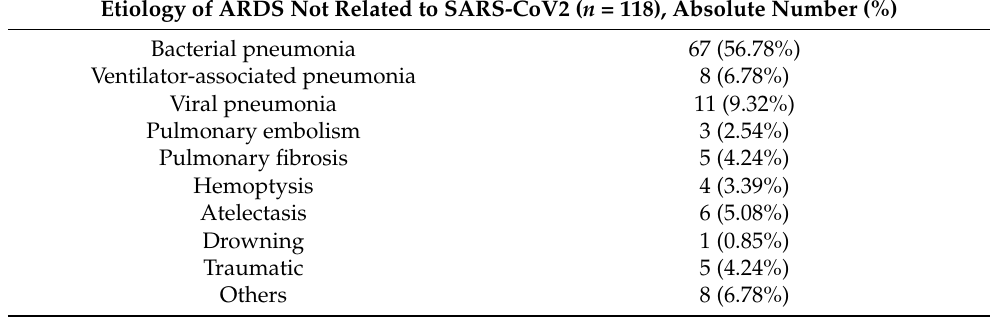
Table 6. Etiology of ARDS not related to SARS-CoV2.